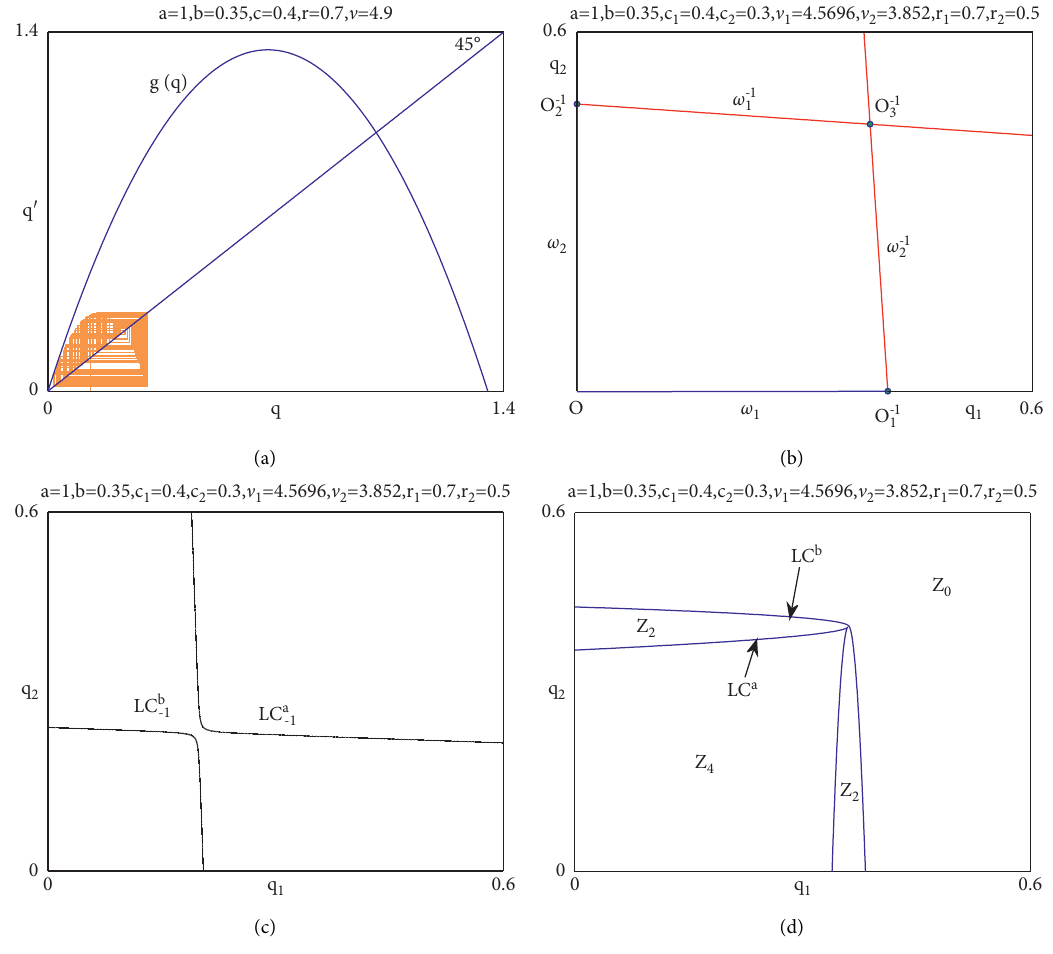
The shape of map T at the values a � 1 ,b � 0 . 35 , c � 0 . 4 ,r � 0 . 7, and ] � 4 . 9. At Δ � 0 . 4 ,c � 0 . 3 , r � 0 . 7 , r � 0 . 5 ,v � 4 . 5696, and v � 3 . 852 v � 3 . 852. (b) The segments ω 1 2 1 2 1 2 2 and the critical curve LC with the corresponding 1